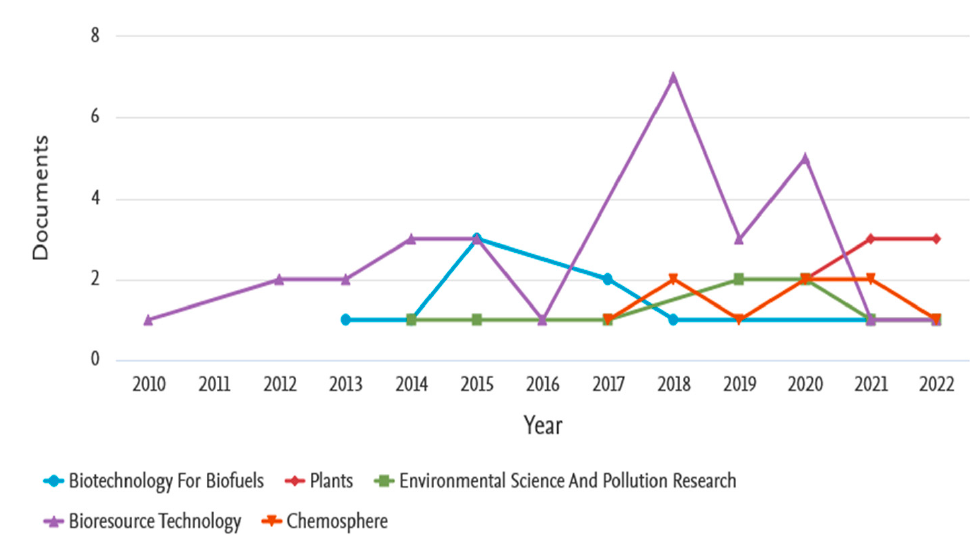
Figure 4. The most productive journals within the analyzed time frame (2022 is not a full year). The most productive was Zhao H, who published 33 papers; the second most pro- ductive was Fang Y, with 28 papers. Appenroth K. J. was third with 20 published articles (Figure 5).